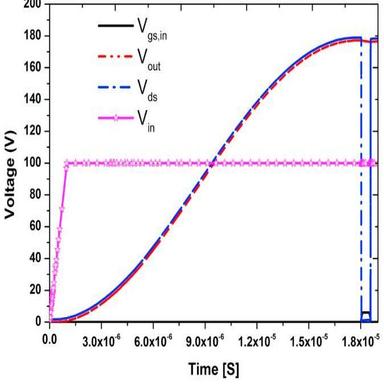
Circuit terminal operating voltage waveform at various device terminals of the circuit versus time measured at a switching frequency of 1 MHz. The input/output voltages observed are 100/182 V.